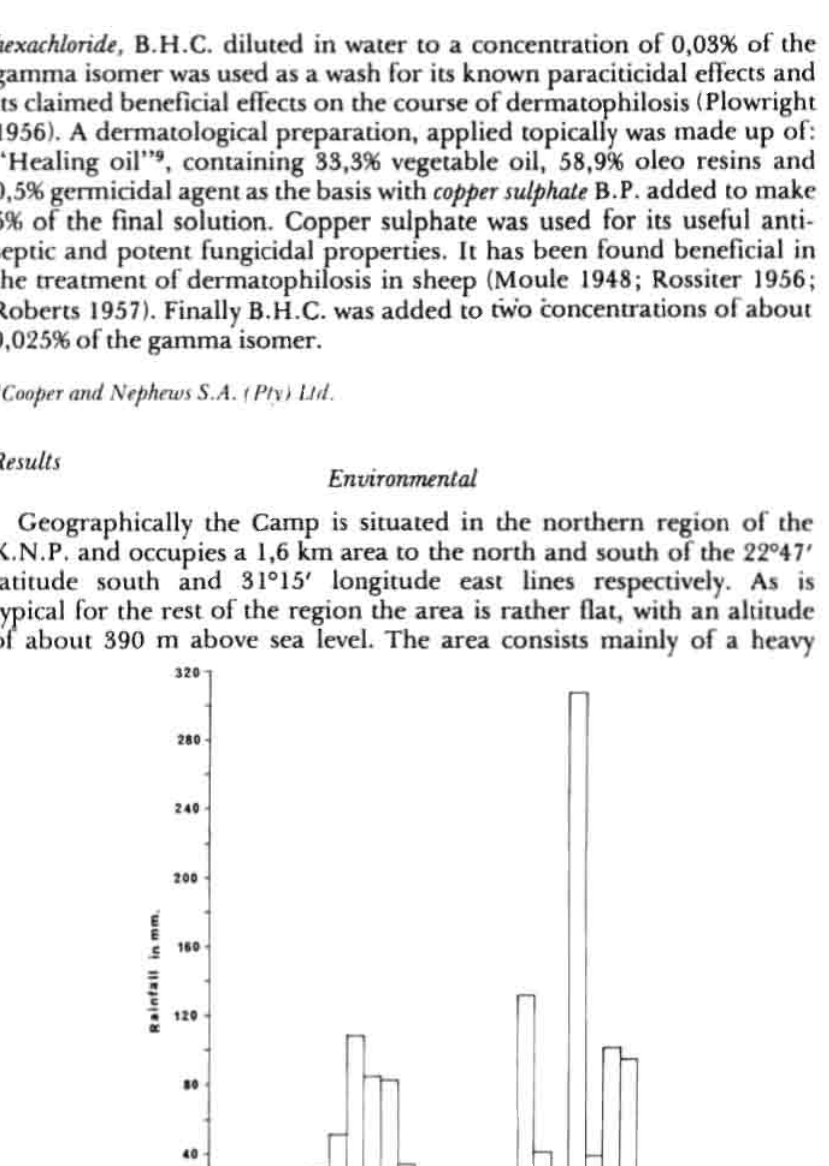
Fig. 1. H iSlOgram of the monthly rainfall dislribulion for Shingwedzi Rest C,lJnp, Kruger National Park, during the period of and directly prt·, ceding the outbreak of dermalOphilosis. Yearly rainfall figures are included li)r comparative